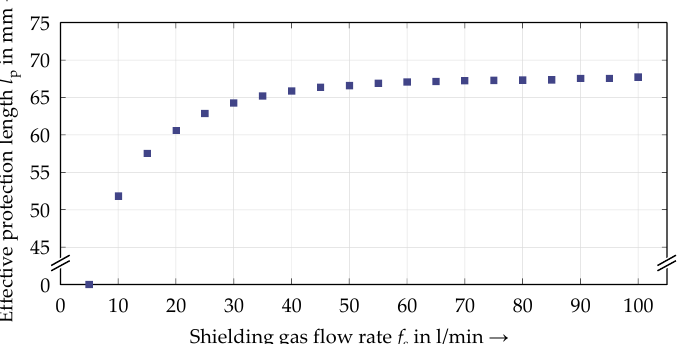
Figure 7. Effect of the shielding gas flow rate on the effective protection length (indicated by the blue markers) on the substrate plane at a stand-off distance of 10 mm obtained from the simulations.